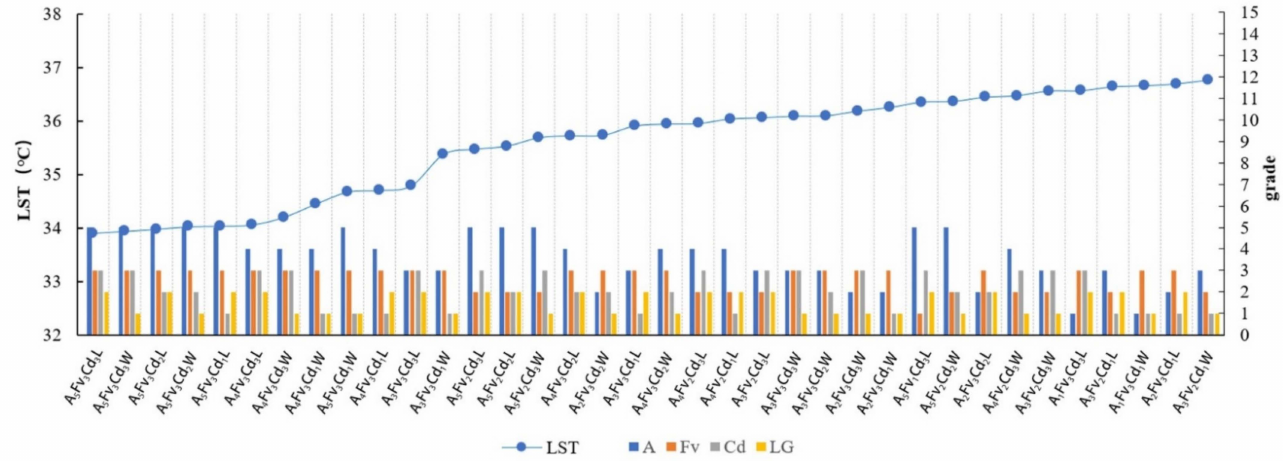
Figure 16. Sorted MG types with LST values lower than 36.8 ◦ C in the Width-III river buffer zone and the linear correlation between the MG types and their LST values.